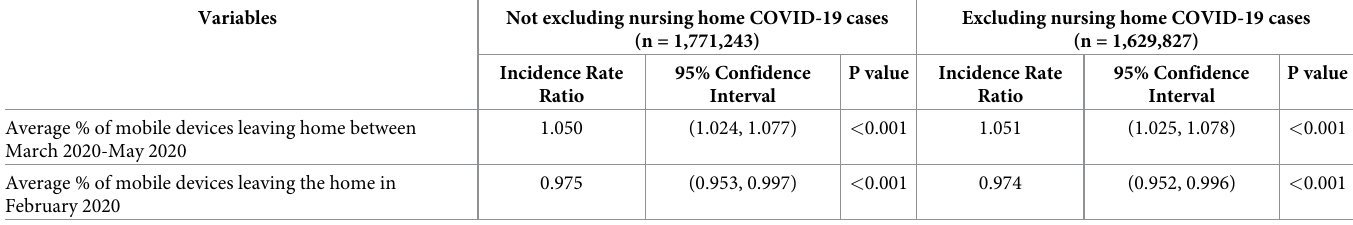
Table 1. Mixed-effects negative binomial model assessing influence of social distancing behavior on US COVID-19 cases (cases/100,000 people) between when a county had its first confirmed case and May 31 st , 2020.